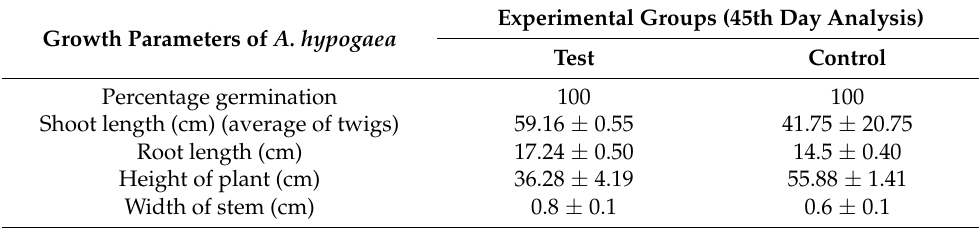
Table 4. Influence of Kosakonia sp. MGR1 on physiological properties of A. hypogaea . Growth Parameters of A.